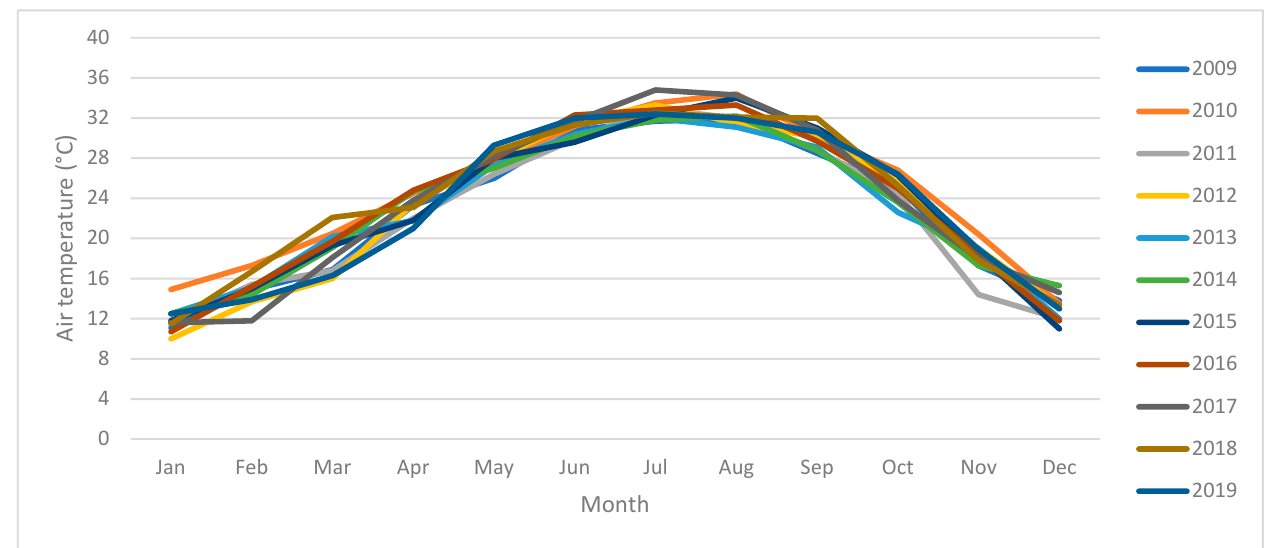
Figure 5. The average air temperature data from 2009 to 2019. Source: NASA Surface Meteorology and Solar Energy.